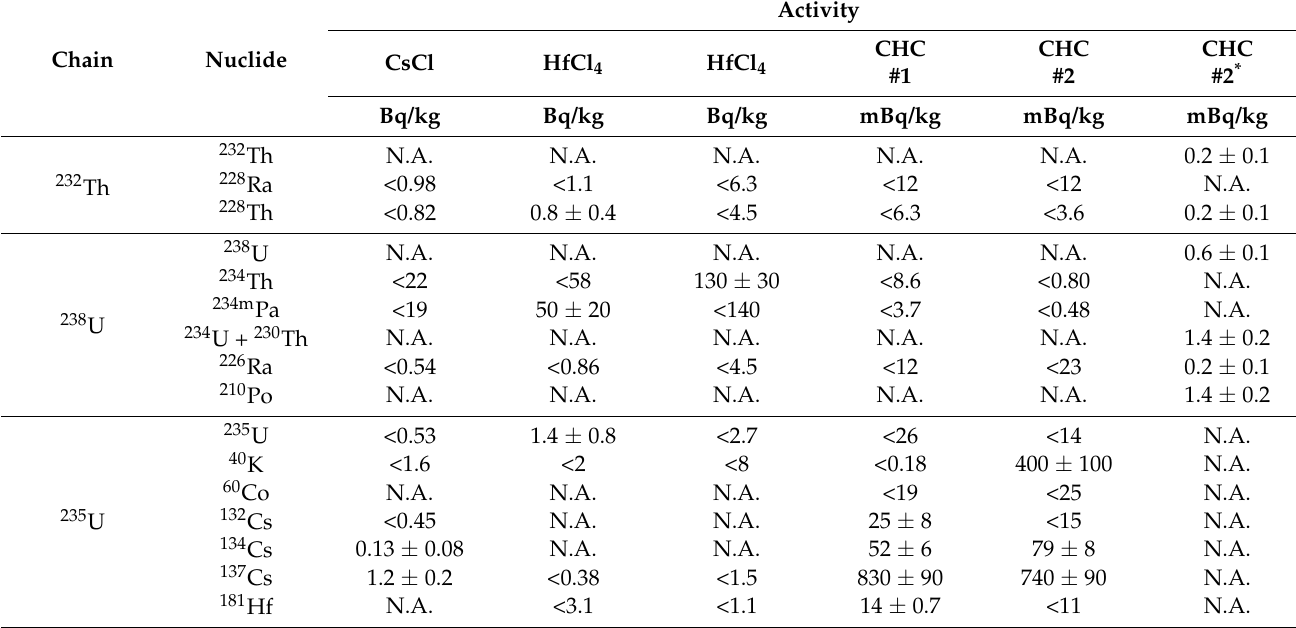
Table 6. The internal radioactive contamination. Activities of radioactive nuclides determined for the entire production chain of Cs 2 HfCl 6 (CHC) crystal #1 (as-received CsCl, initial HfCl 4 powder, HfCl 4 powder after 3-fold sublimation, as- grown CHC crystal #1) and the CHC crystal #2 were measured with low-background HPGe gamma-spectrometer. Activities listed in the last column (CHC crystal #2 * ) were evaluated from selected by pulse shape analysis “pure” alpha events spectrum collected over 2848 h in long-term low-background measurements of CHC crystal in scintillating mode (see text). All limits are at 90% C.L. N.A. means “not